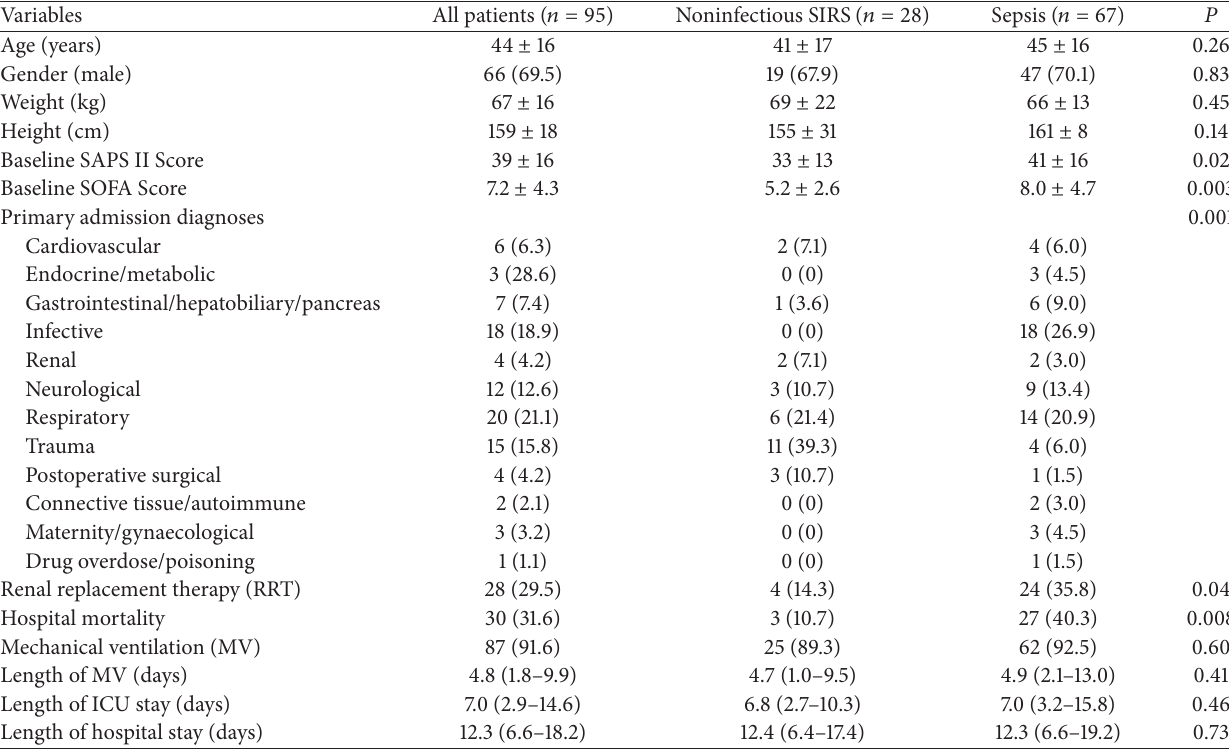
Table 1: Baseline demographics, clinical characteristics, and outcomes between patients with SIRS and sepsis.